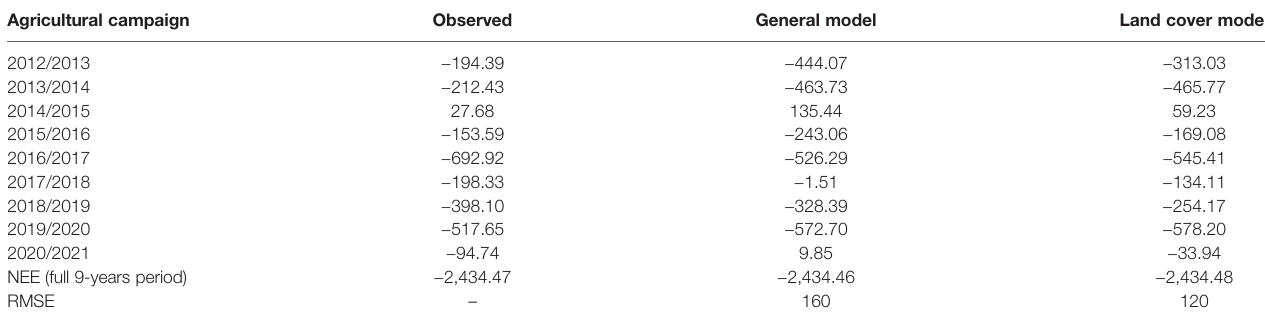
TABLE 3 | Observed and predicted NEE in yearly agricultural campaigns, from June to May, with RMSE estimates.